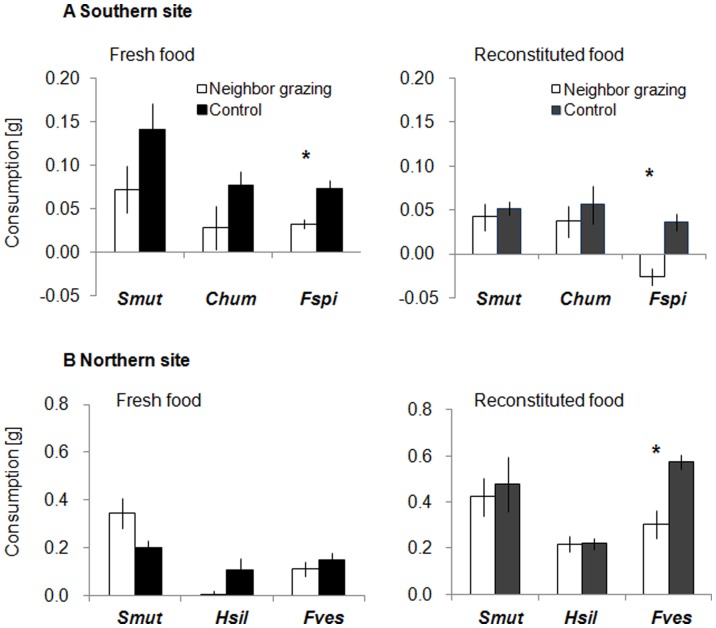
Effects of waterborne cues on conspecific seaweeds.Mean consumption (±SE) of fresh and reconstituted seaweed pieces by the isopod Stenosoma nadejda from the southern site (A) and Idotea baltica from the northern site (B) in two-choice feeding assays. The seaweed species Sargassum muticum (Smut), Cystoseira humilis (Chum), Halidrys siliquosa (Hsil), Fucus spiralis (Fspi) and F. vesiculosus (Fves) used in the assays were positioned downstream of grazed ( = cue-exposed) and ungrazed ( = control) con-specifics in the induction phase. Negative values in consumption of reconstituted food indicate lower losses in mass by consumption than increases in mass by non-consumptive effects, e.g. absorption of water. Almost identical consistency and same volume of reconstituted food will result in same magnitude of non-consumptive effects on wet mass change during assays and allow interpretation of preferences between treated and control pieces. Asterisks show significant differences in consumption between cue-exposed and control feed (n = 8). Note different scaling of ordinate between southern and northern sites.